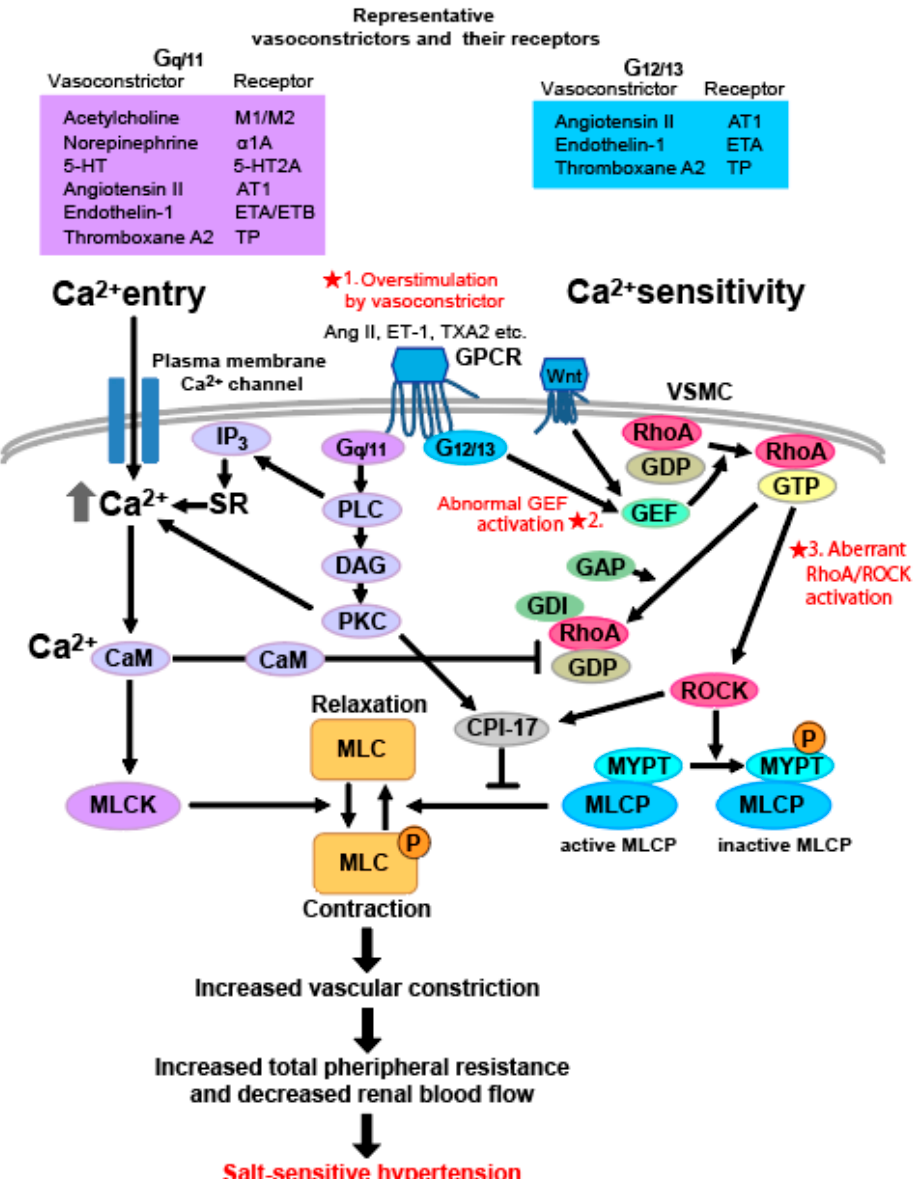
Figure 1. Mechanism of Rho-associated salt-sensitive hypertension in vascular smooth muscle cells (VSMCs) and representative vasoactive peptide coupling to G-protein-coupled receptors (GPCRs) G q/11 and G 12/13 . There are three mechanisms of Rho-associated salt-sensitive hypertension in VSMCs. These include the stimulation of VSMCs by increased responsible vasoconstrictors such as angiotensin II (Ang II), endothelin-1 (ET-1), and thromboxane A2 (TXA2) in the blood ( (cid:70) 1), abnormal activations of Rho-guanine nucleotide exchange factors (GEFs) ( (cid:70) 2), and aberrant activation of Rho/Rho-associated protein kinase (ROCK) by, for example, Wnt noncanonical pathway in aging ( (cid:70) 3). These, via Ca 2+ influx into the cells ( (cid:70) 1) and increased Ca 2+ sensitivity ( (cid:70) 1–3), induce VSMCs contraction and increase vasoconstriction, which increases peripheral vascular resistance and decreases renal blood flow, resulting in salt-sensitive hypertension. In VSMC, phosphorylation